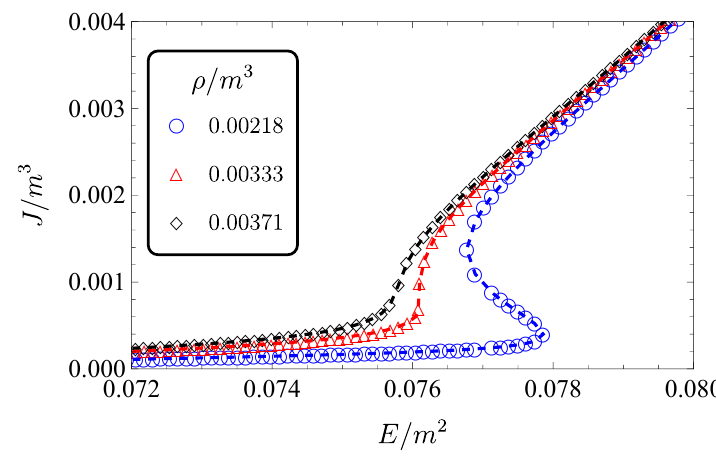
Figure 1 . J - E characteristics for several ρ/m 3 with T